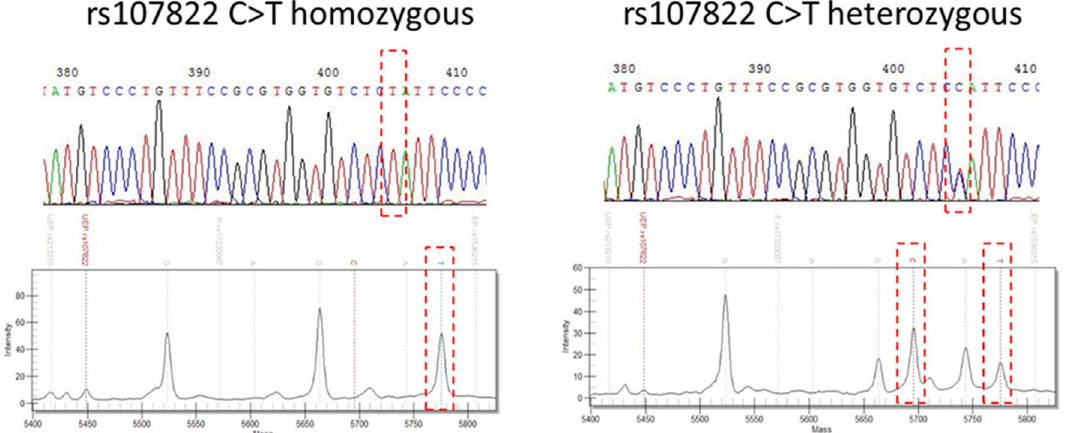
Figure 1. The comparisons of MassARRAY and Sanger sequencing. The y-axis of MassARRAY plot is referred to peak intensity and the x-axis of MassARRAY plot is referred to mass (daltons). Mass spectrum of a sample showing a single peak of 5785 Da (left) indicating TT genotype. Mass spectrum of a sample showing peaks at both 5695 Da and 5785 Da indicating CT